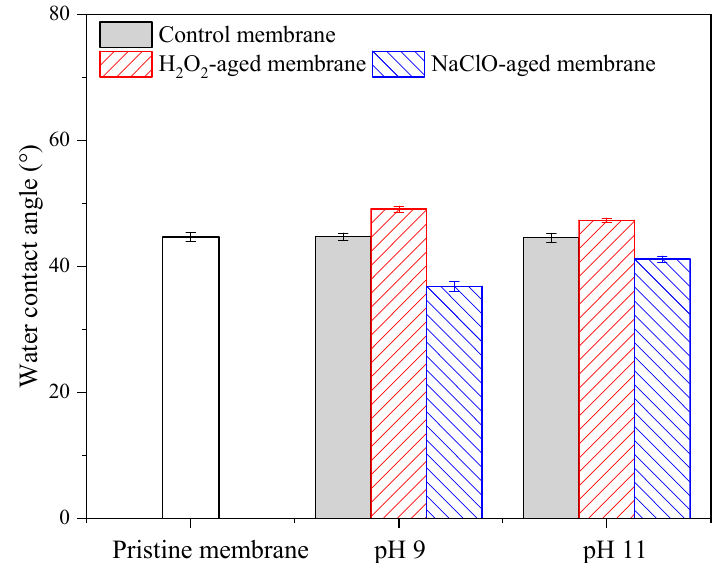
Figure 7. E ff ects of H 2 O 2 and NaClO aging on pure water contact angle of PES membrane. Control Figure 7. Effects of H 2 O 2 and NaClO aging on pure water contact angle of PES membrane. membrane indicates membrane samples aged in NaOH solution with pH 9 or 11, c(H 2 O 2 ) = c(NaClO) Control membrane indicates membrane samples aged in NaOH solution with pH 9 or 11, = 5000 mg / L, t = 100 h, and error bars indicate standard deviation of triplicate samples. c(H 2 O 2 ) = c(NaClO) = 5000 mg/L, t = 100 h, and error bars indicate standard deviation of triplicate samples.